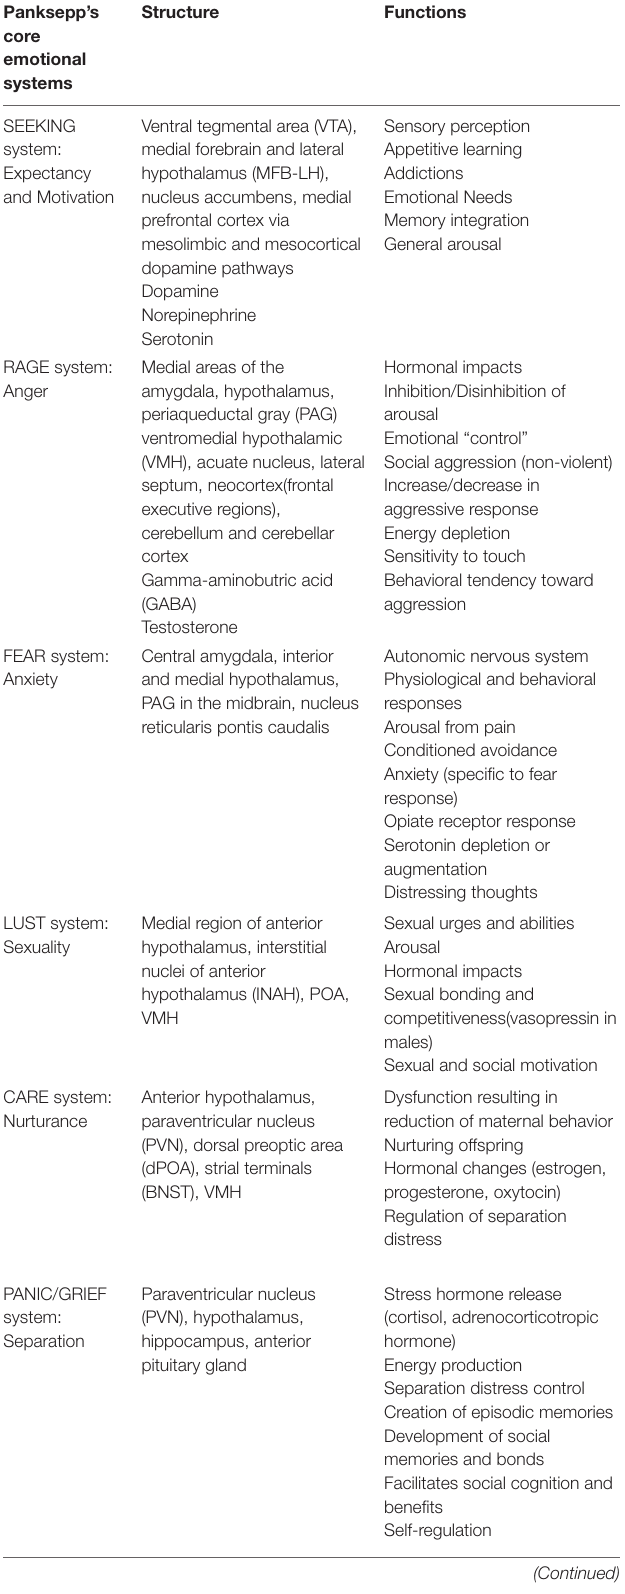
TABLE 3 | Seven core emotional systems. Panksepp’s core emotional